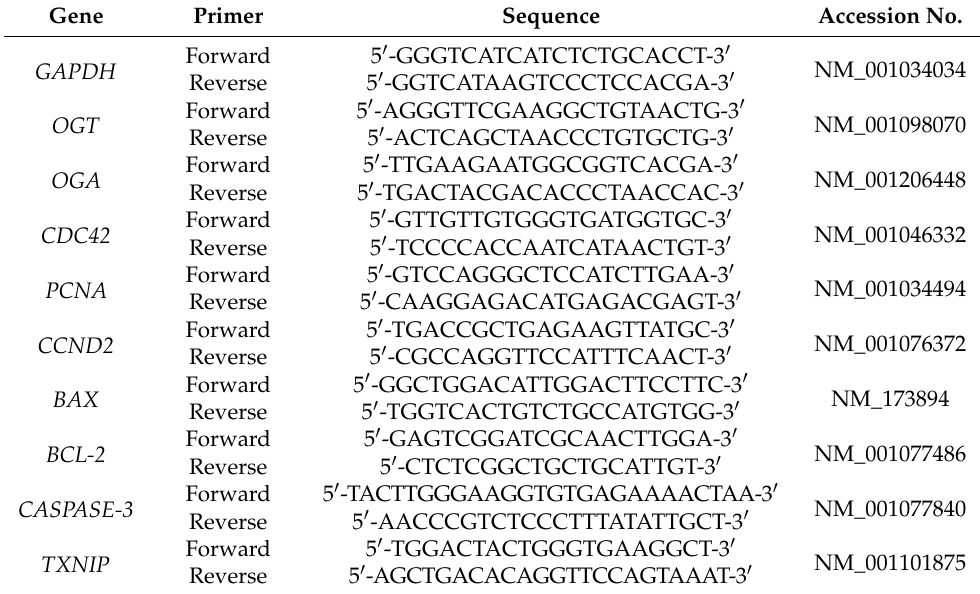
Table 1. Primer sequences used for